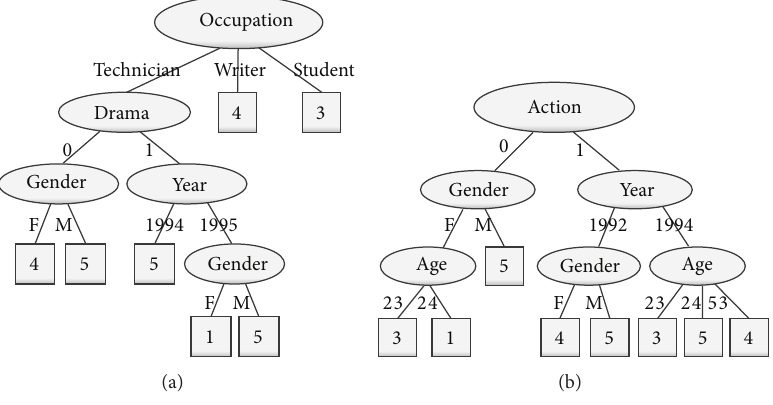
Figure 2: Samples of random decision